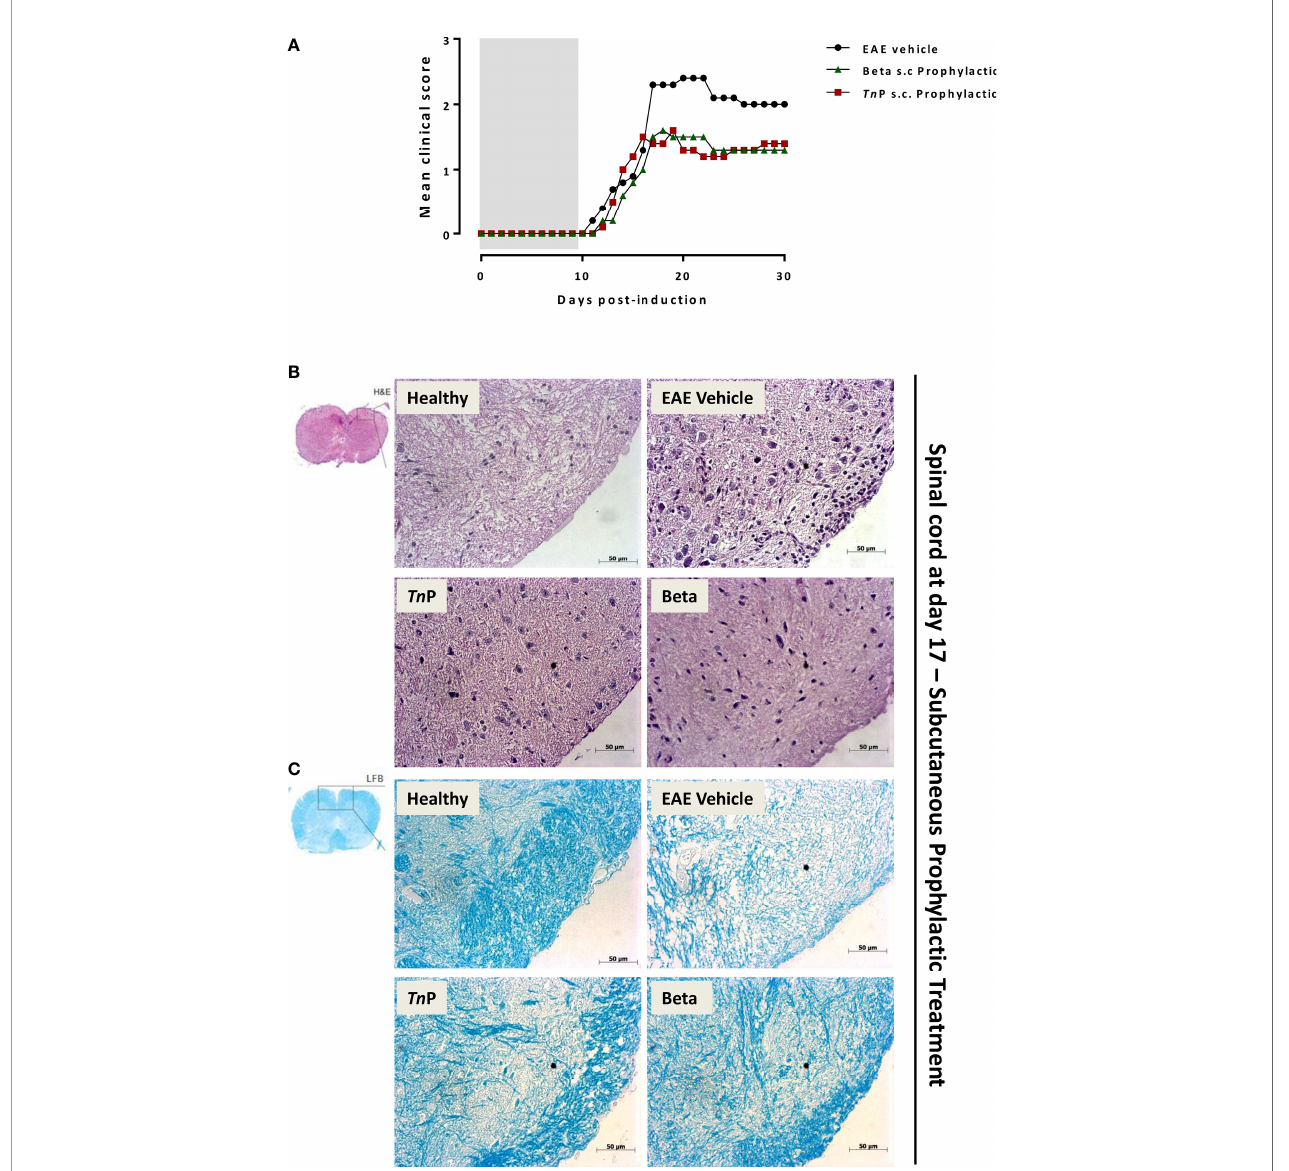
FIGURE 1 | Tn P improves EAE clinical signs and controls in fl ammation and demyelination compared to betaseron. BL6 mice (n = 5/group) immunized with (MOG) peptide in incomplete Freund ’ s adjuvant added with M . tuberculosis were injected 2 times with Pertussis toxin after immunization. Mice were scored (0 – 5) daily for 30 d for evidence of clinical signs of disease (A) . Mice were s.c. treated with Tn P at 3 mg/Kg or betaseron at 10,000 UI/mice every other day starting at the day 0 of immunization until day 9 (prophylactic regimen). The EAE controls were injected with 0.9% saline alone (Vehicle). Spinal cords from healthy, vehicle-treated EAE, and EAE treated-mice were removed on the peak of disease (17) and stained in with H&E (B) in the upper panels or Luxol fast blue in the lower ones (C) . Representative sections are